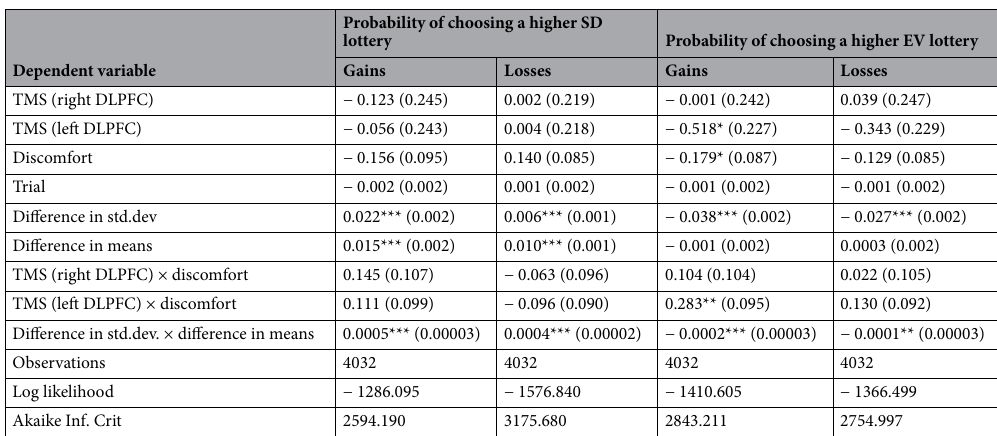
Table 4. Effects of the right/left DLPFC TMS on the behaviour in a binary lottery choice task on a trial-by- trial level relative to sham. All regressions are mixed-effect generalized linear models with a logit link function and subject-level random effects. Columns 1 and 2 use probability of choosing a riskier (higher SD) lottery as a dependent variable. Columns 3 and 4 use probability of choosing a lottery with higher expected reward (higher EV) as a dependent variable. ***p < 0.001; **p < 0.01; *p < 0.05. Standard errors in parentheses.